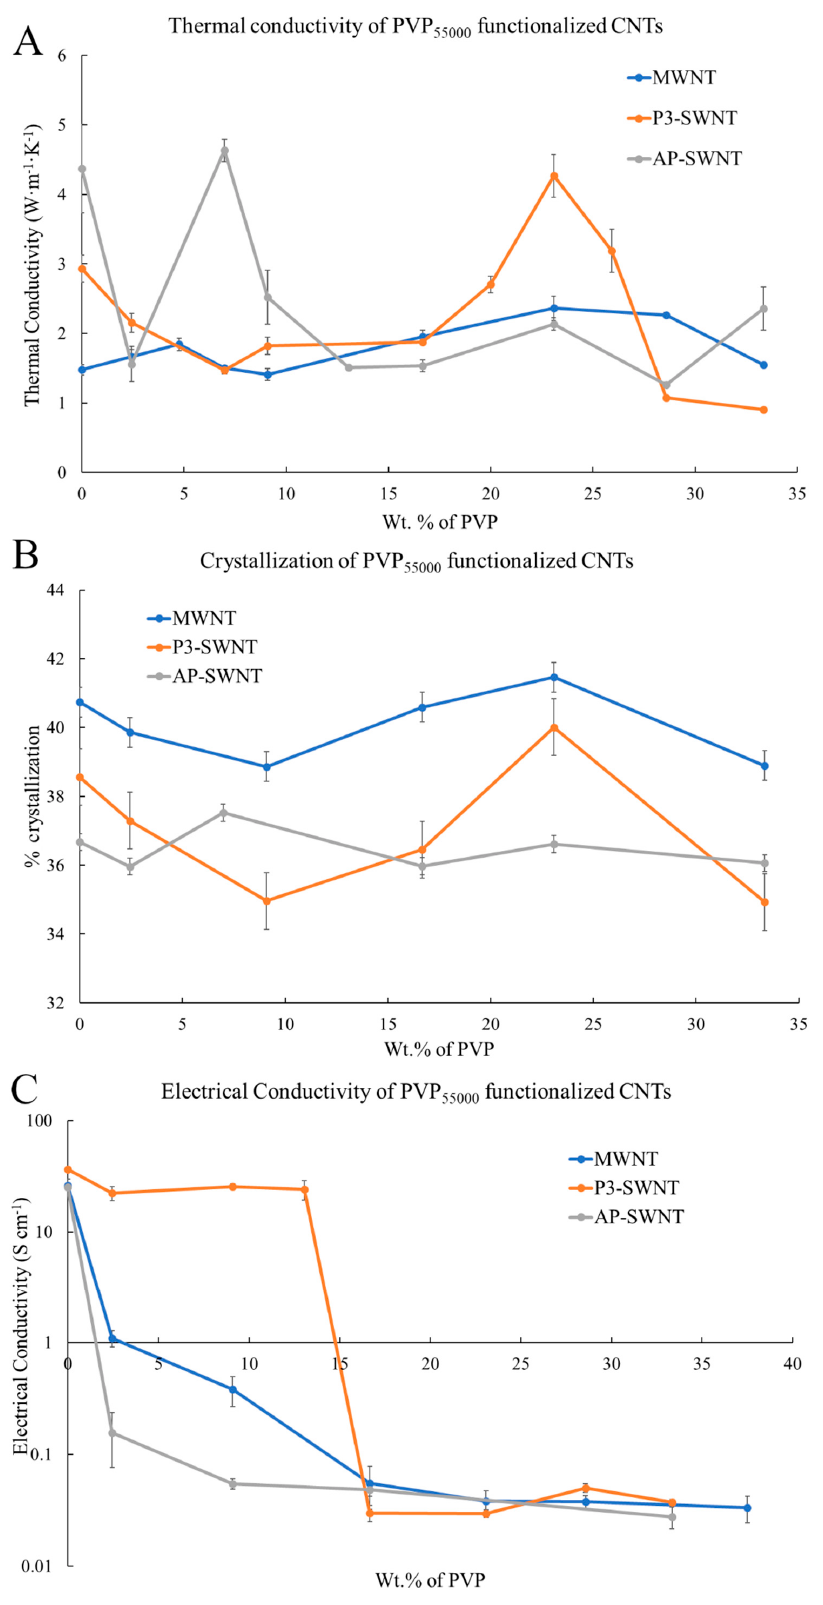
Figure 5. ( A ) Thermal conductivity of three different types of PVP 55000 functionalized CNT/PVDF composites; ( B ) Percent Crystallization; and ( C ) Electrical conductivity of PVP 55000 functionalized CNT/PVDF composites at different PVP